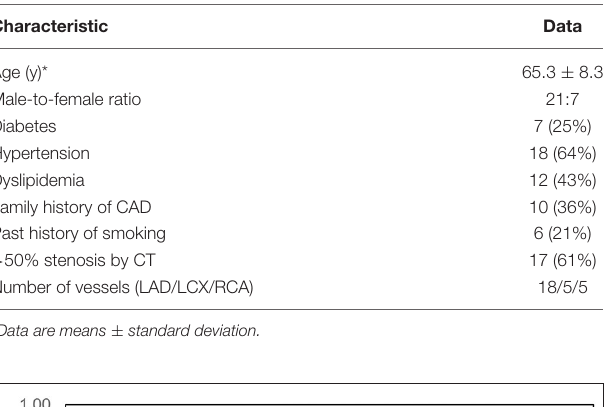
TABLE 1 | Baseline patient characteristics.